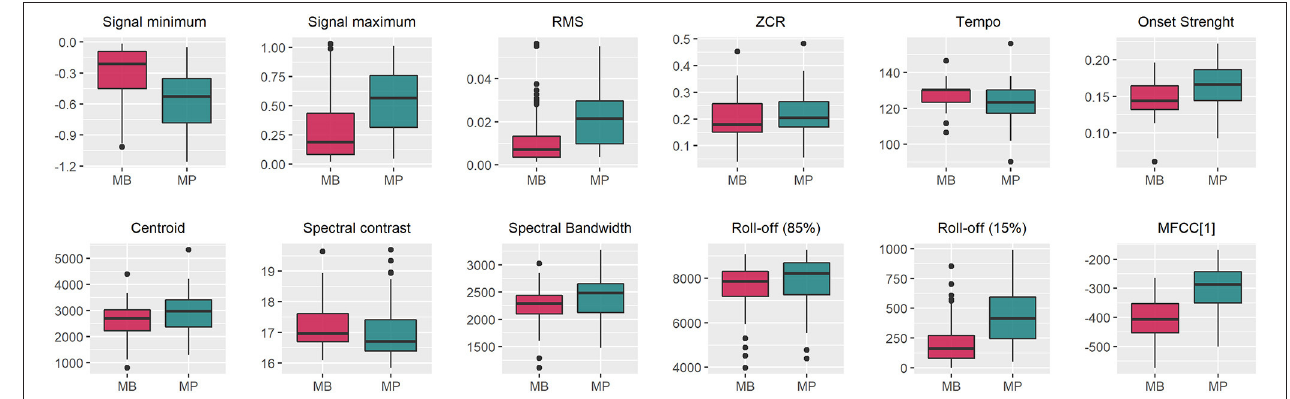
FIGURE 5 | Boxplots for features extracted from audio data of Brazilian horses gaiting according to two different gait types ( marcha batida —MB and marcha picada —MP). ZCR, Zero Crossing Rate; MFCC[1], First component of the Mel-frequency cepstrum coefficients. The Onset Strength, Centroid, Spectral Contrast, Spectral Bandwidth, Roll-off, MFCC[1] were computed by averaging the values of the whole feature vector for each training data sample.